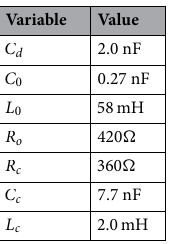
Table 2. Estimated values of the equivalent circuit parameters in Fig. 3d.